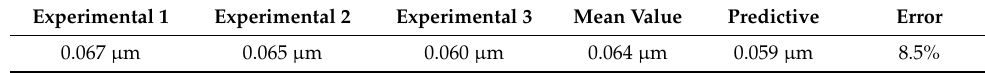
Table 6. Experimental results of optimal parameters.